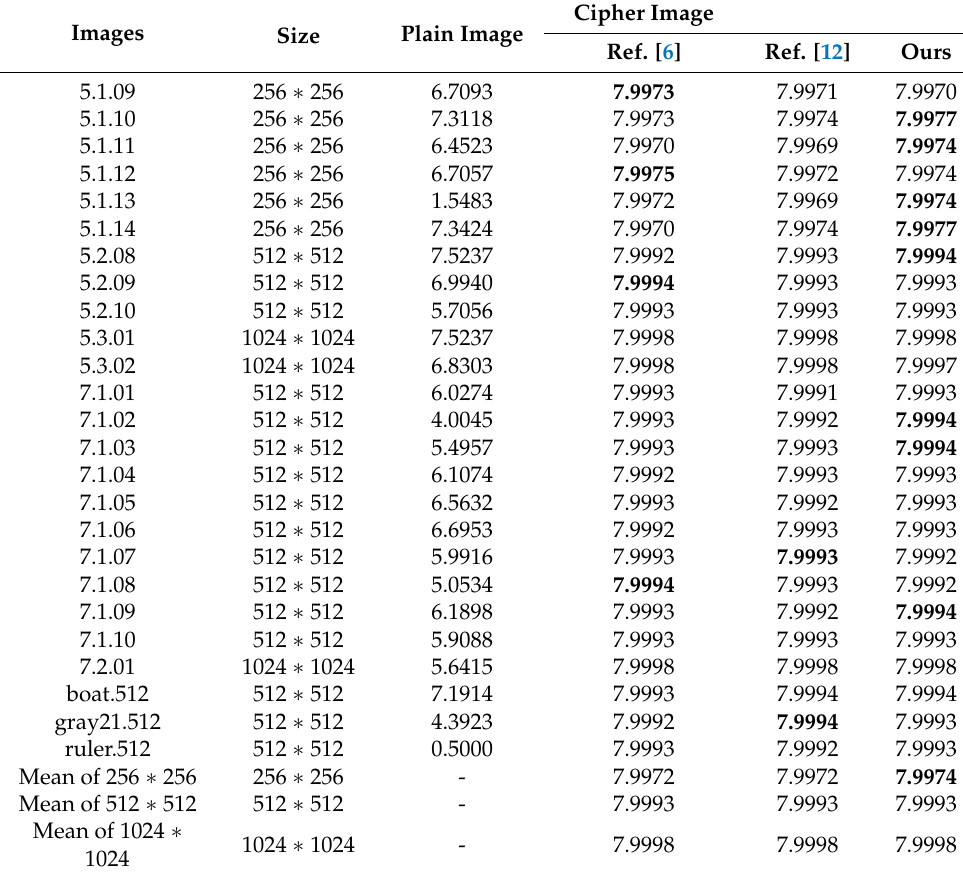
Table 4. Information entropy of encrypted